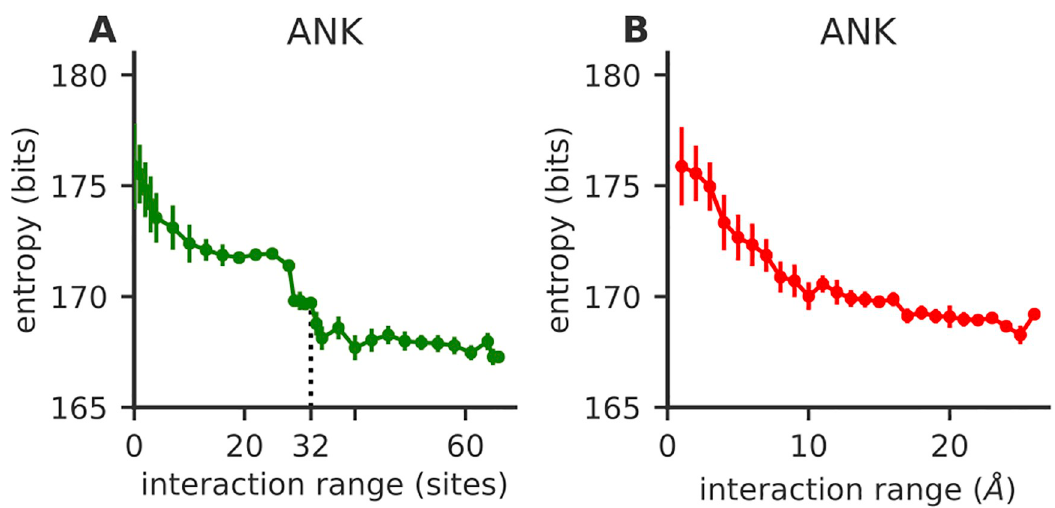
Fig 3. Entropy reduction as a function of the range of interactions between residue sites. A) Entropy of two consecutive ANK repeats, as a function of the maximum allowed interaction distance W along the linear sequence. The entropy of the model decreases as more interactions are added and they constrain the space of possible sequences. After a sharp initial decrease at short ranges, the entropy plateaus until interactions between complementary sites in neighbouring repeats lead to a secondary sharp decrease at W = L − 1 = 32 (dashed line), due to structural interactions between consecutive repeats. B) Entropy of two consecutive ANK repeats as a function of the maximum allowed three-dimensional interaction range. The entropy decreases rapidly until * 10 Angstrom, after which decay becomes slower. In both panels entropies are averaged over 10 realizations of fitting the model; See Methods for details of the learning and entropy estimation procedure. Error bars are estimated from fitting errors between the data and the model; see Methods and S1 Fig for error bars calculated as standard deviations over 10 realizations of model